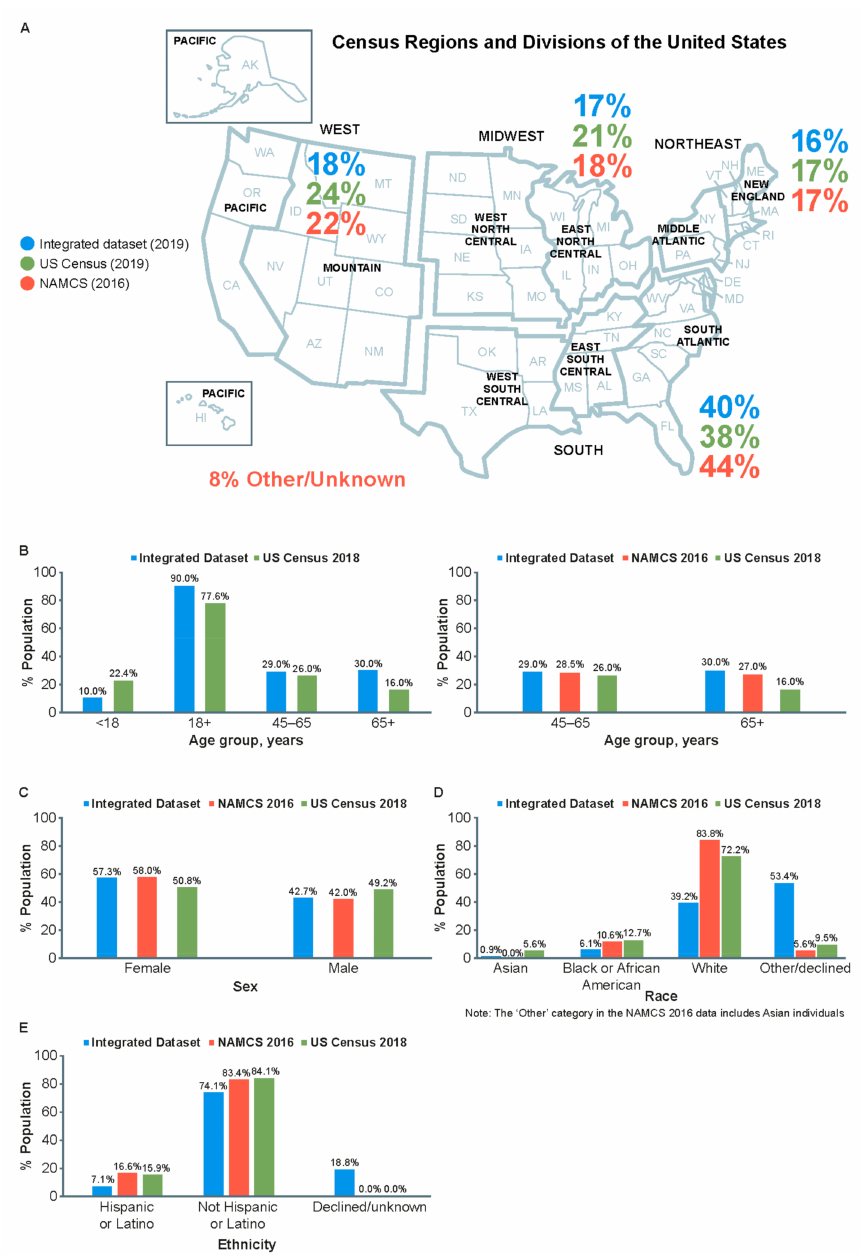
Figure 1. Geographic distribution of all subjects ( n = 123,229,120, representing the full integrated dataset of EMR and both open and closed medical claims from 2014 to 2019) ( A ) and distribution by age ( B ), sex ( C ), race ( D ), and ethnicity ( E ) within the Integrated Dataset versus 2018 US Census and 2016 NAMCS data. EMR: electronic medical record. NAMCS: National Ambulatory Medical Care